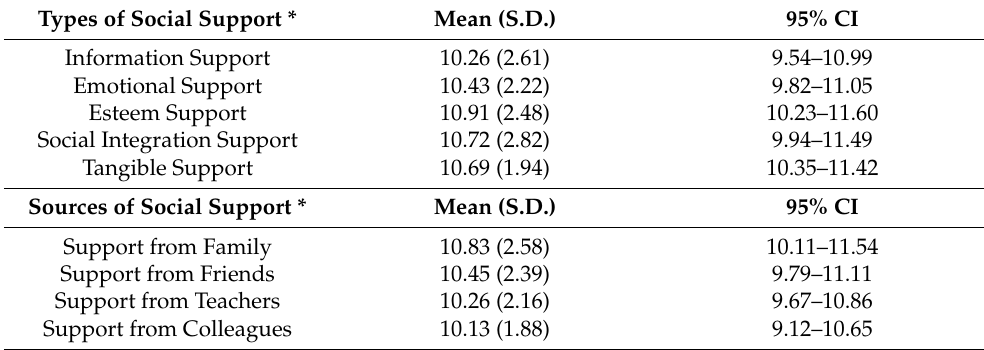
Table 2. Mean scores on types and sources of social support accessible to university students with disabilities during the COVID-19 pandemic in Saudi Arabia (n = 53). Values of skewness and kurtosis of all study variables are reported in Table S3 in Supplementary File A.